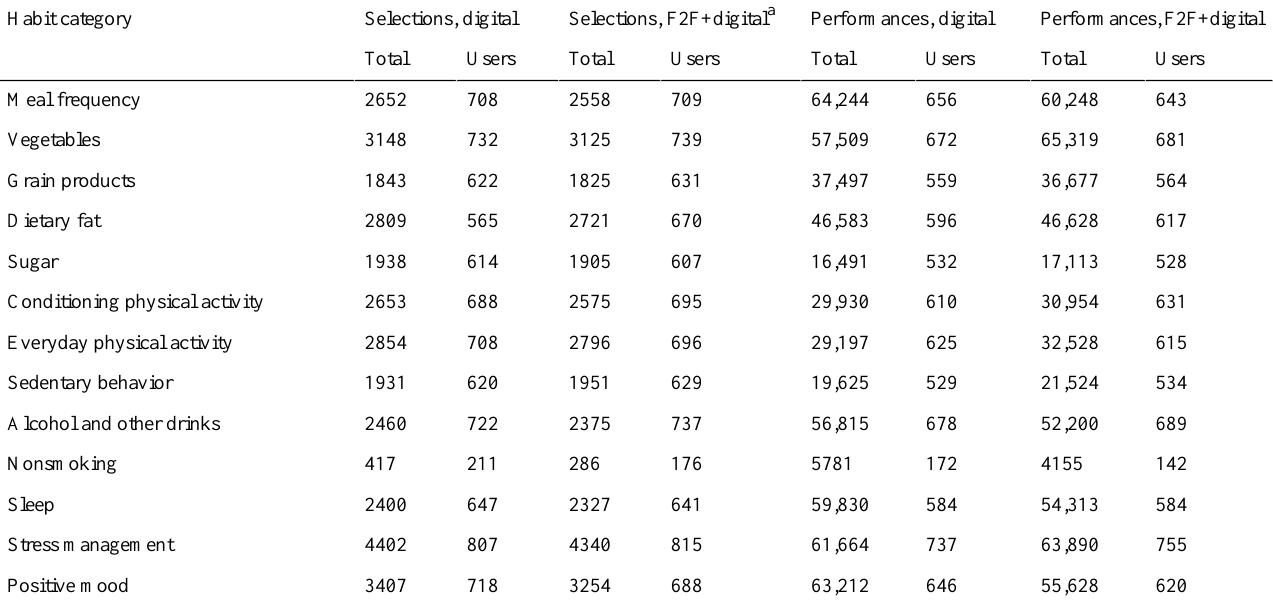
Table 5. The number of selections and users and the number of habit performances and users per